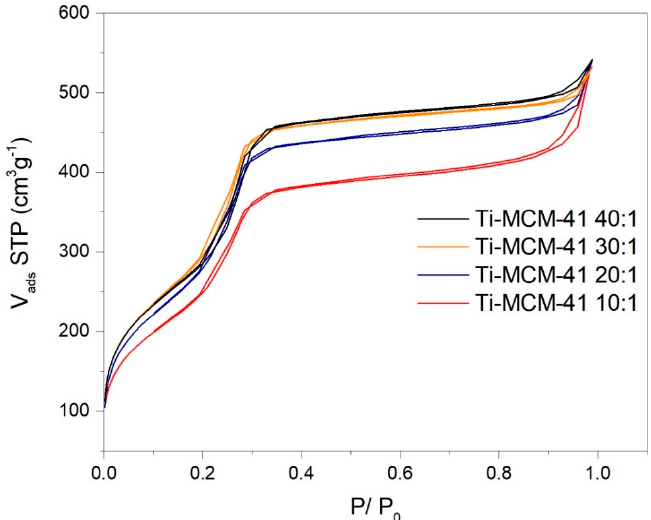
Figure 7. N 2 adsorption–desorption isotherms of Ti-MCM-41 catalysts with different molar ratios of Si:Ti in the crystallization gel (respectively, 40:1, 30:1, 20:1, and 10:1).